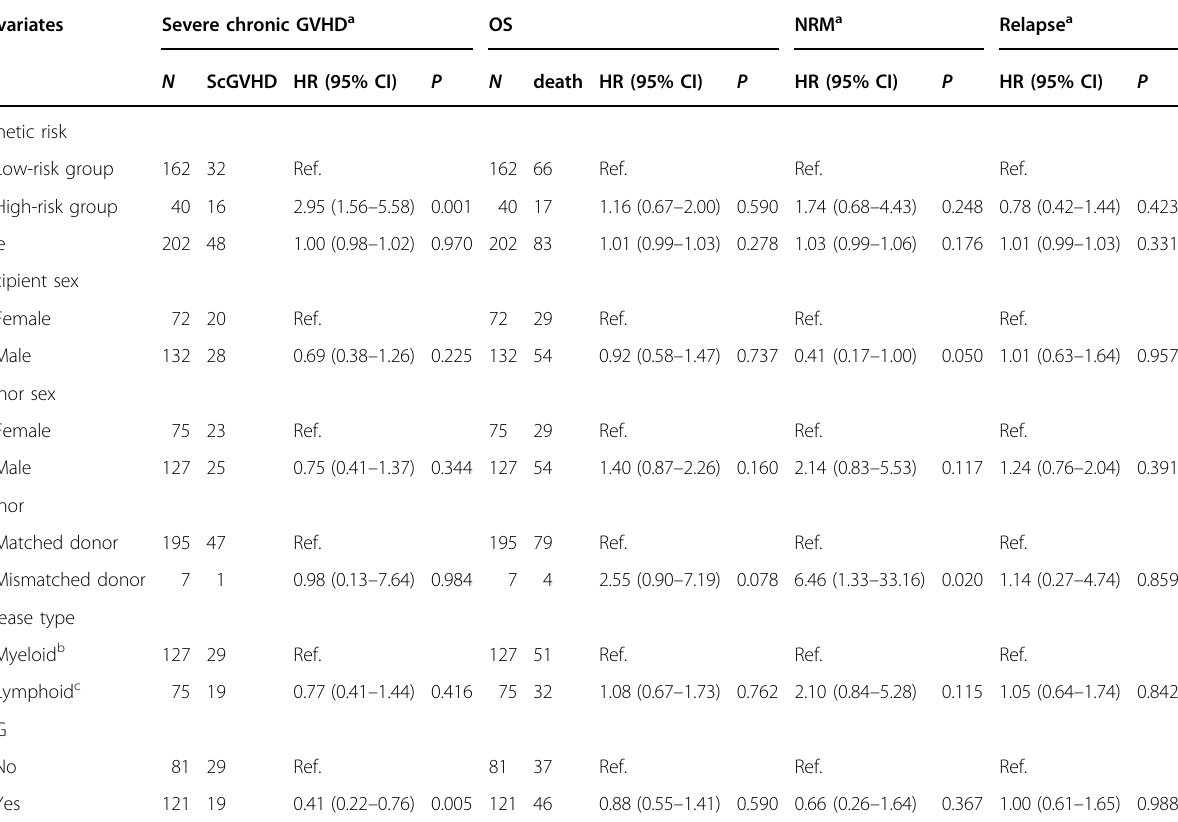
Table 3 Multivariable analysis of the incidence of severe cGVHD, OS, NRM, and relapse in the validation cohort.